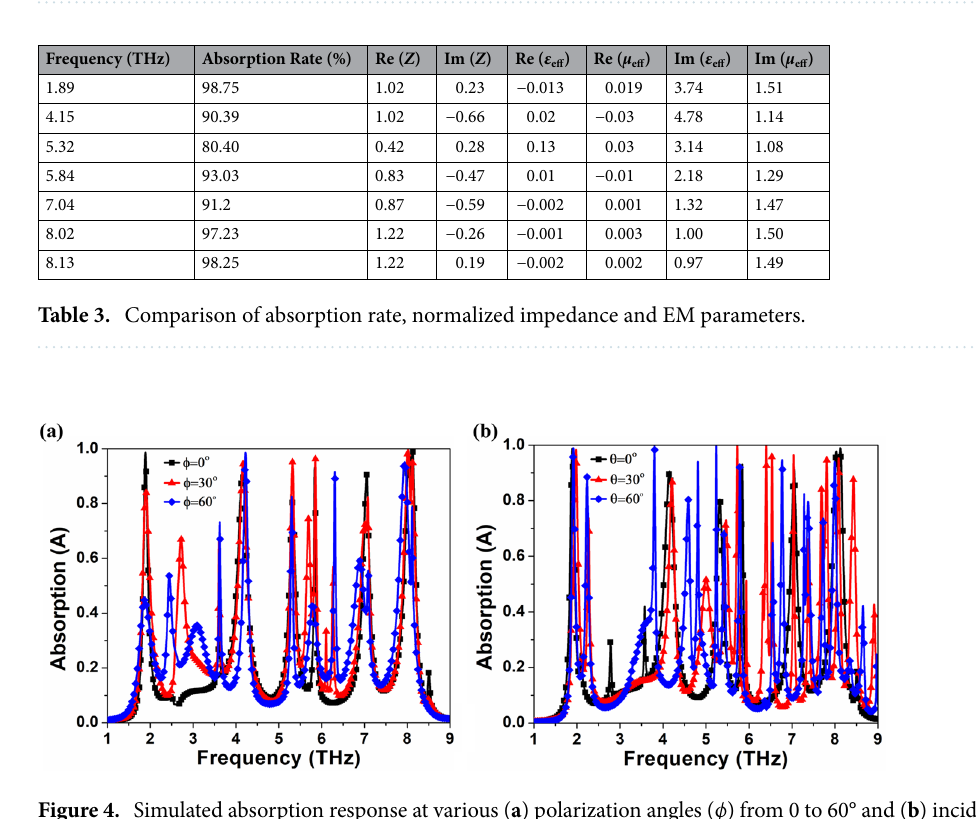
Figure 4. Simulated absorption response at various ( a ) polarization angles ( ϕ ) from 0 to 60° and ( b ) incident angles ( θ ) from 0 to